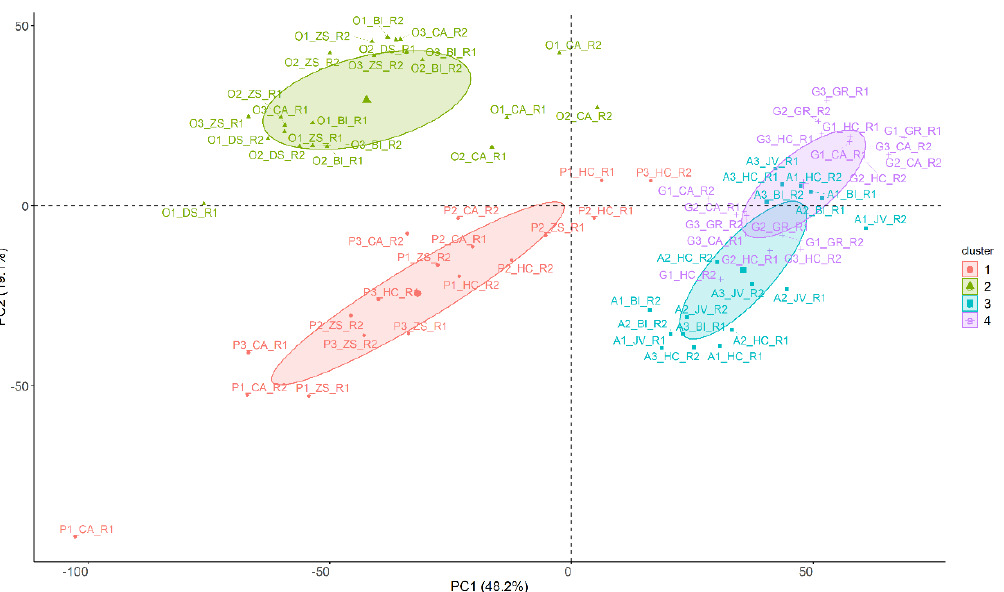
Figure 2. Representation of the samples as a function of the first two components using spectroscopic data matrix D 76×4190 . The samples have been colored and symbolized according to the group obtained by the model-based clustering (VVI distribution), where the centroid of each group is represented by the respective larger symbol and its distribution is shown as an ellipse.